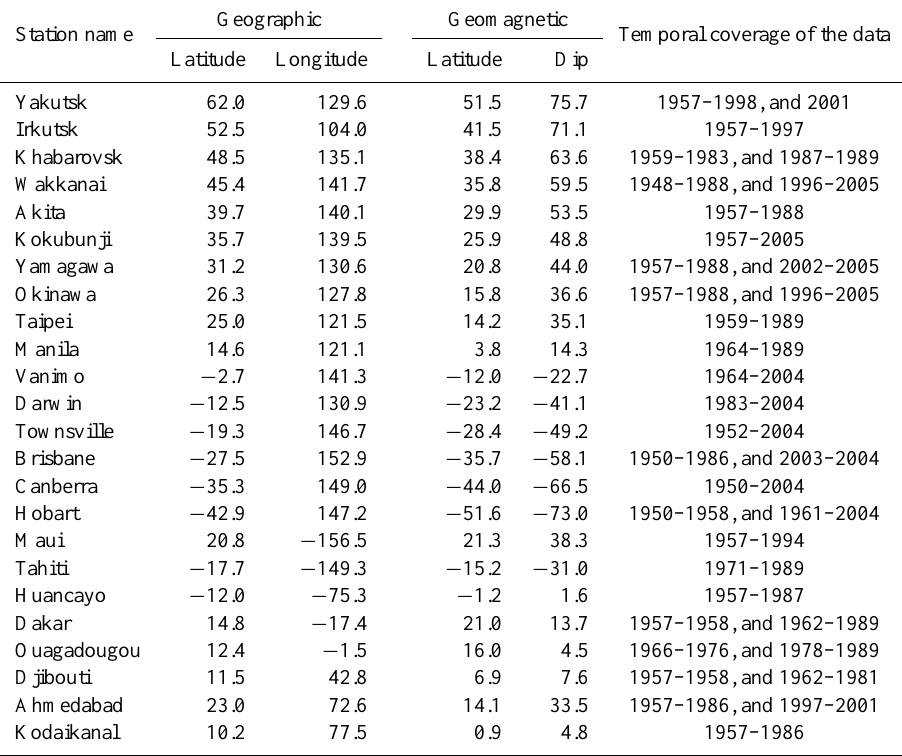
Table 1. Information of the ionosonde stations used in this